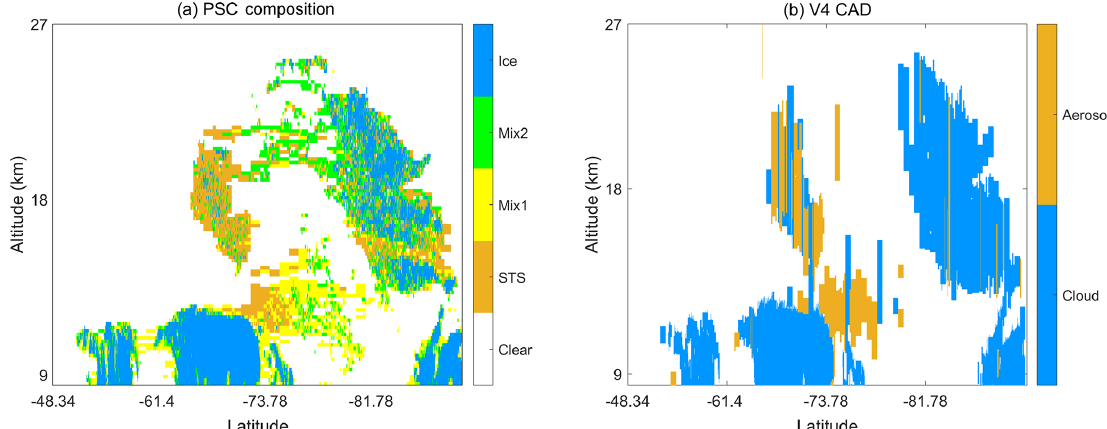
Figure 20. Spatial distributions of profiles of (a) STS from the CALIPSO PSC product and (b) stratospheric aerosol from the CALIPSO V4